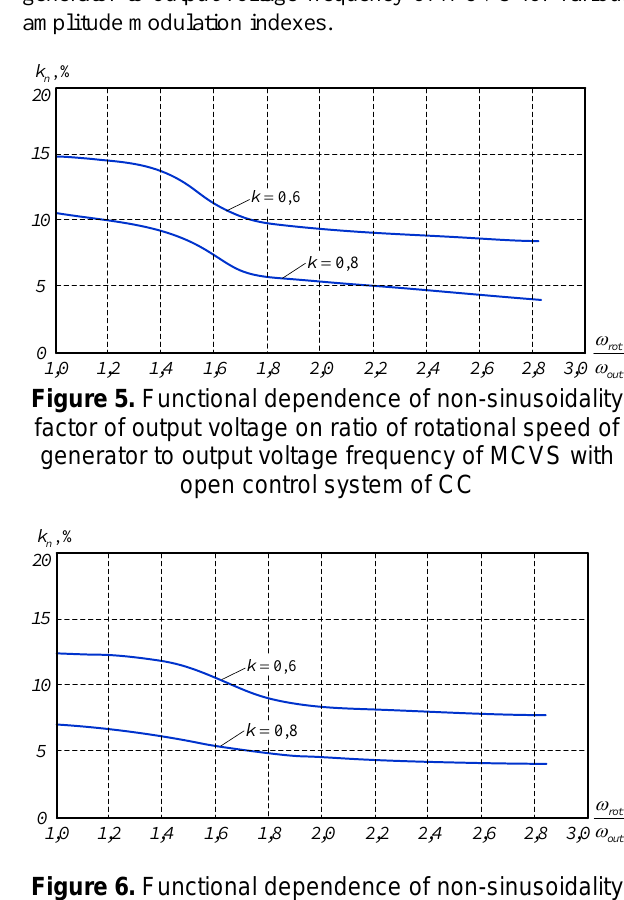
Figure 6. Functional dependence of non-sinusoidality factor of output voltage on ratio of rotational speed of generator to output voltage frequency of MCVS with